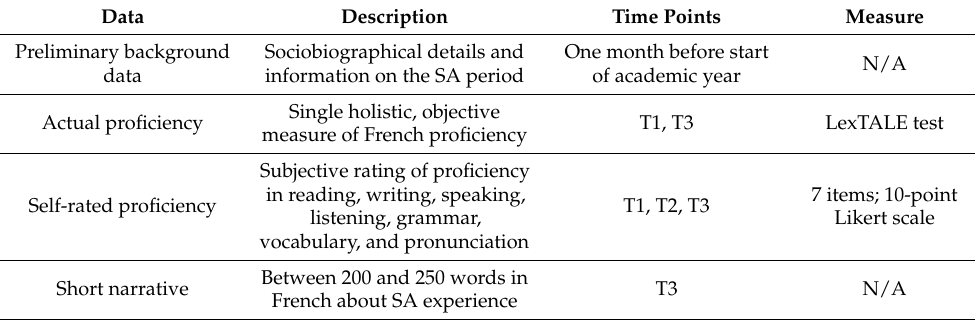
Table 1. Timing of the data